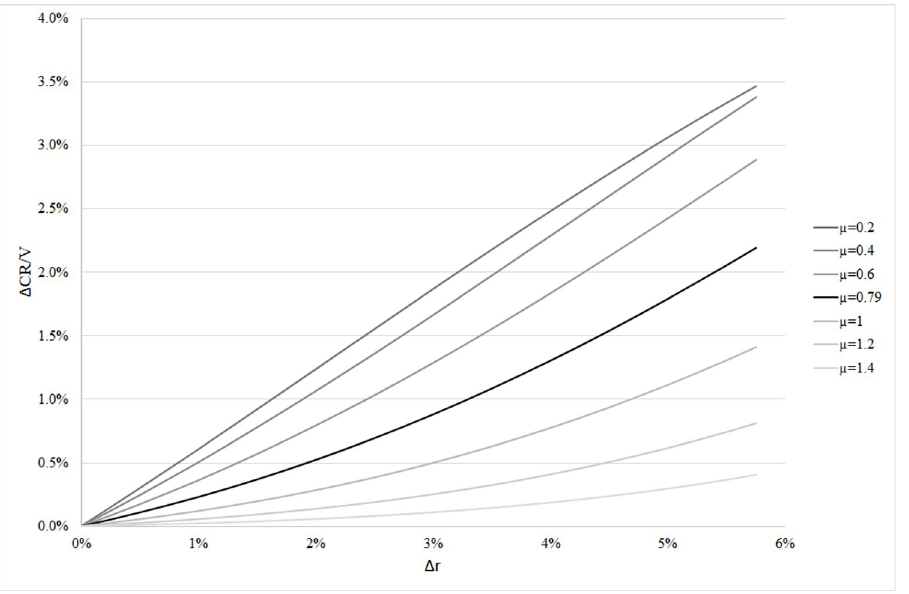
Fig 4. Additional capital need of ARM loans at EU Level as a function of Δ r and µ .